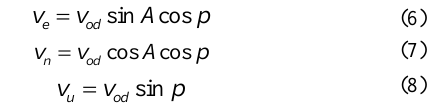
Figure 4. DR navigation system scheme based on CPD heading change and vehicle information